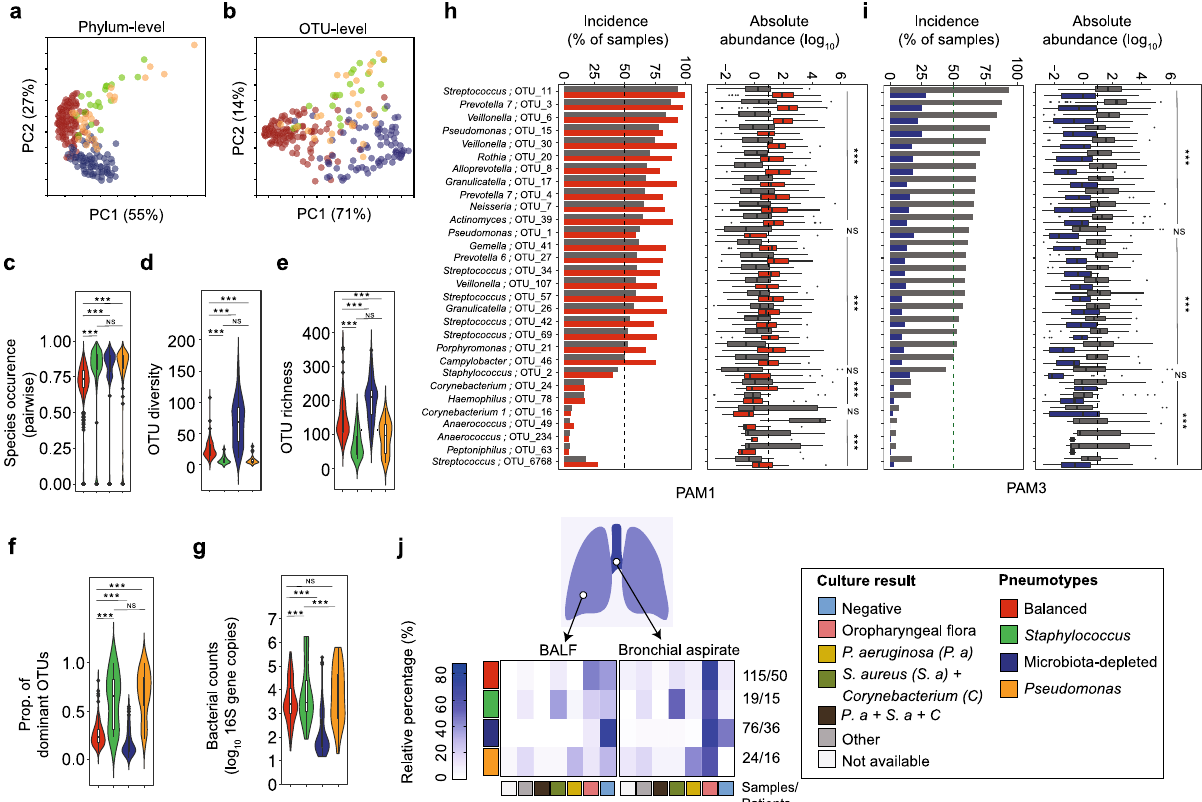
Fig. 3 Bacterial communities of the lung post-transplant fall into four ‘ pneumotypes ’ with distinct community characteristics. a, b Principal component analysis shows Partition around medoids (PAMs) at phylum and OTU level respectively generated by k -medoid-based unsupervised machine learning using Bray – Curtis dissimilarity (occurrence and abundance). Pneumotypes are color coded: Balanced (red, n = 115), Staphylococcus (green, n = 19), Microbiota-depleted (MD, blue, n = 76), and Pseudomonas (orange, n = 24). c – g Violin plots show distributions of pairwise species occurrence (Sorenson ’ s index, PERMANOVA, two-sided, F (3, 229) = 8.49, P = 9.9 × 10 − 5 ), OTU diversity (Kruskal – Wallis test, χ 2 = 89.2, df = 3, two-sided, P = 2.2 × 10 − 16 ), OTU richness (ANOVA, F (3, 229) = 43.9, two-sided, P = 2.2 × 10 − 16 ), proportion of most dominant OTUs (Kruskal – Wallis test, χ 2 = 94.45, df = 3, two-sided, P = 2.2 × 10 − 16 ), and total bacterial counts (ANOVA, F (3, 229) = 43.9, two-sided, P = 2.2 × 10 − 16 ), respectively, across the four pneumotypes. h , i Enrichment analysis of prevalence (green dotted line ≥ 50%) and absolute abundance across all samples of the 30 most dominant taxa (i.e., OTUs) in Pneumotype Balanced and Pneumotype MD respectively, when each was compared to the other three combined pneumotypes (gray boxes). Differential abundances after enrichment analysis was calculated between each PAM and the other three PAMs combined, using ART-ANOVA. j Heatmap shows relative percentage of taxa (right colored panel) cultured from paired samples of Bronchial aspiration (BA) and Bronchoalveolar lavage fl uid (BALF) from each pneumotype (left colored panel). Oropharyngeal fl ora mainly corresponds to Pneumotype Balanced (i.e., Streptococcus, Prevotella , Veillonella ). All box plots including insets show median (middle line), 25th, 75th percentile (box) and 5th and 95th percentile (whiskers) as well as outliers (single points). Multiple comparison of beta diversity indices was done by pairwise PERMANOVA ( adonis ) with False Discovery rate (FDR). Post hoc analyses (95% Con fi dence Interval) were done by using Tukey ’ s test (ANOVA) or Dunn ’ s test (Kruskal test) with False Discovery Rate (FDR) or least-squares means (ART-ANOVA) with False Discovery Rate (FDR). * P < 0.05, ** P < 0.01, *** P < 0.001, NS = not signi fi